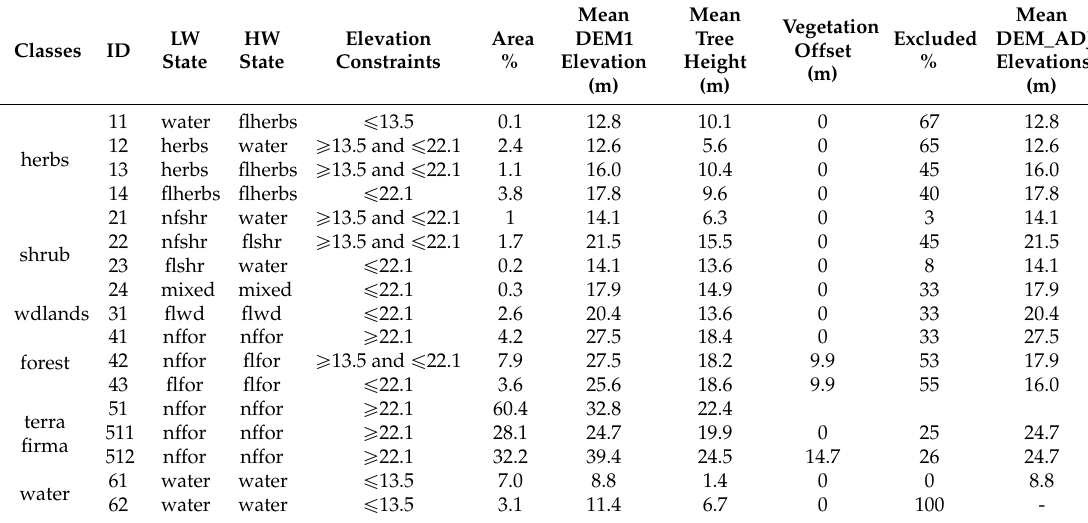
Table 1. Characteristics of the selected regions and proposed elevation